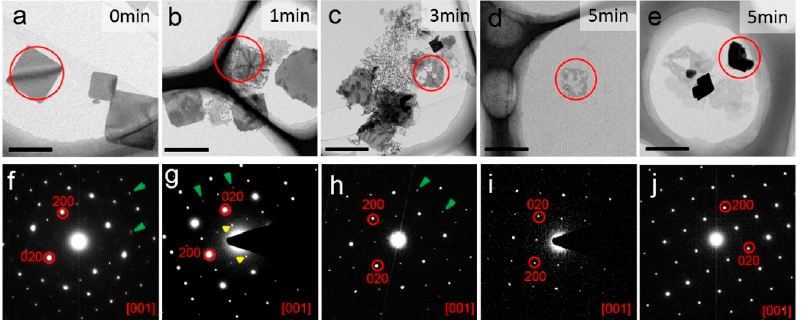
Figure 3. ( a – e ) TEM images of BA 2 PbBr 4 nanosheets after UV irradiation for 0 min, 1 min, 3 min, and 5 min (bar = 1 µ m); ( f – j ) The corresponding SAED patterns acquired from the circled area in ( a – e ), respectively. Green and yellow arrows indicate the presence of extra diffraction spots.